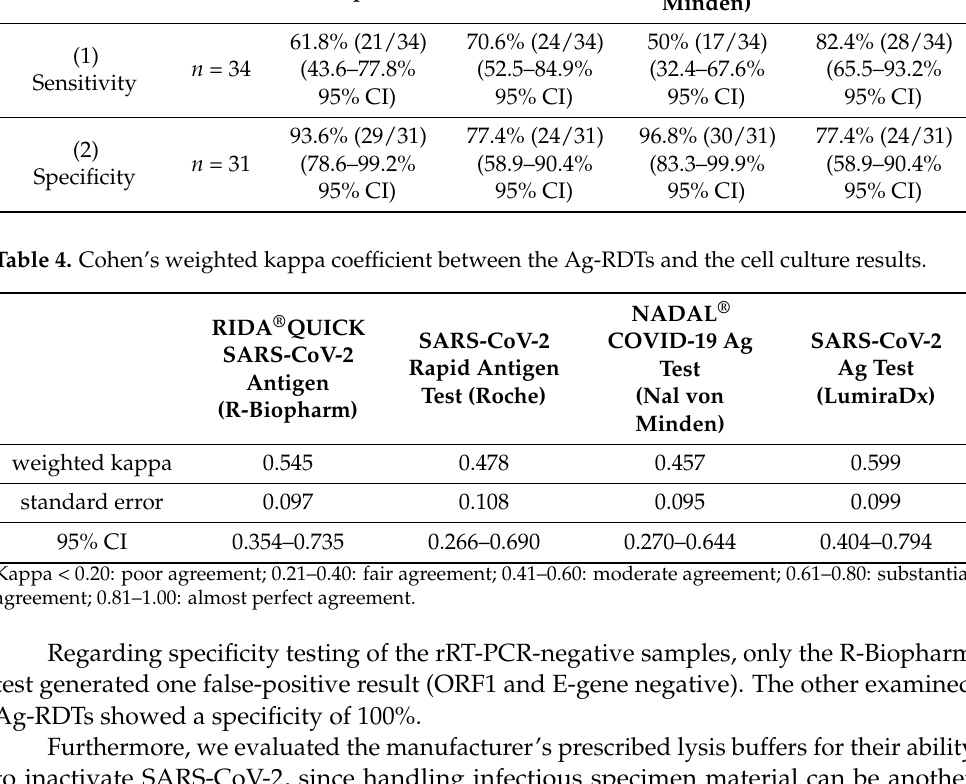
Table 4. Cohen’s weighted kappa coefficient between the Ag-RDTs and the cell culture results.